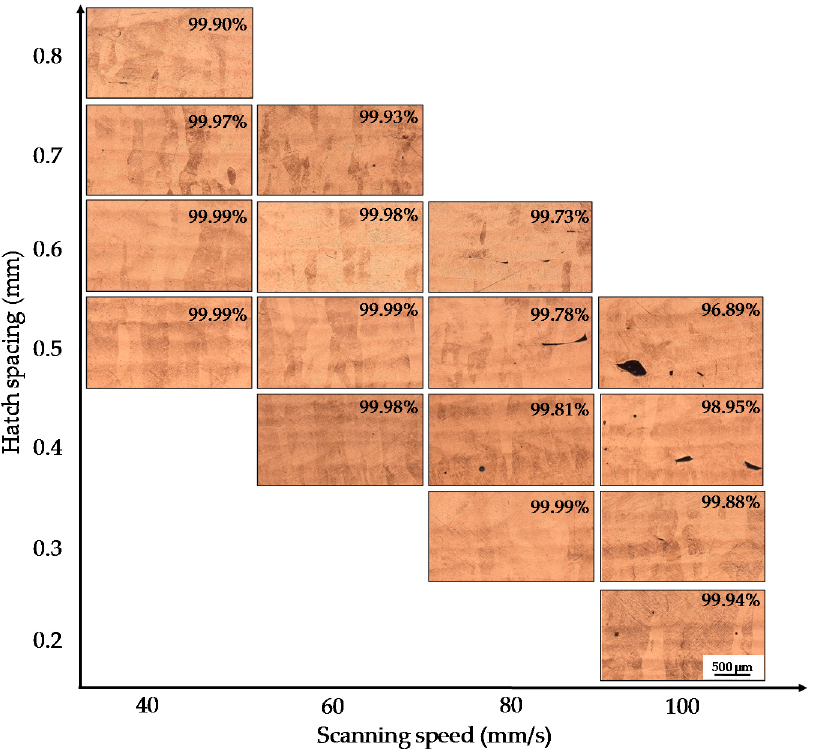
Figure 6. Density behaviors of selective laser melting Ti6Al4V samples with different scanning speeds and hatch spacings ( P = 400 W, δ = 200 μ m).